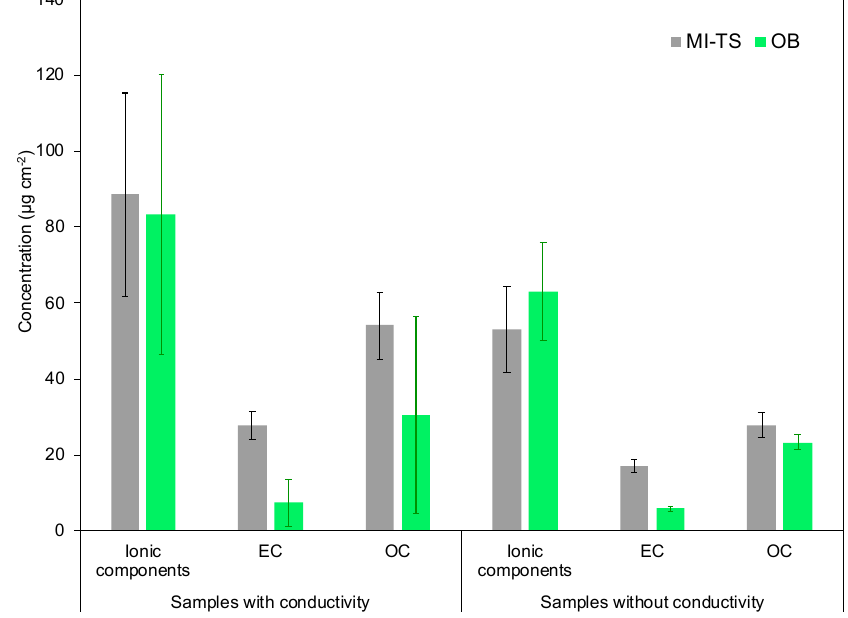
Figure 4. Average surficial mass concentrations ( µ g cm − 2 ) for MI-TS (grey) and OB (green) sample data for the quantified inorganic ionic fraction, EC and OC. Data are reported separately for samples that showed a conductivity and for those where it was not-detected.